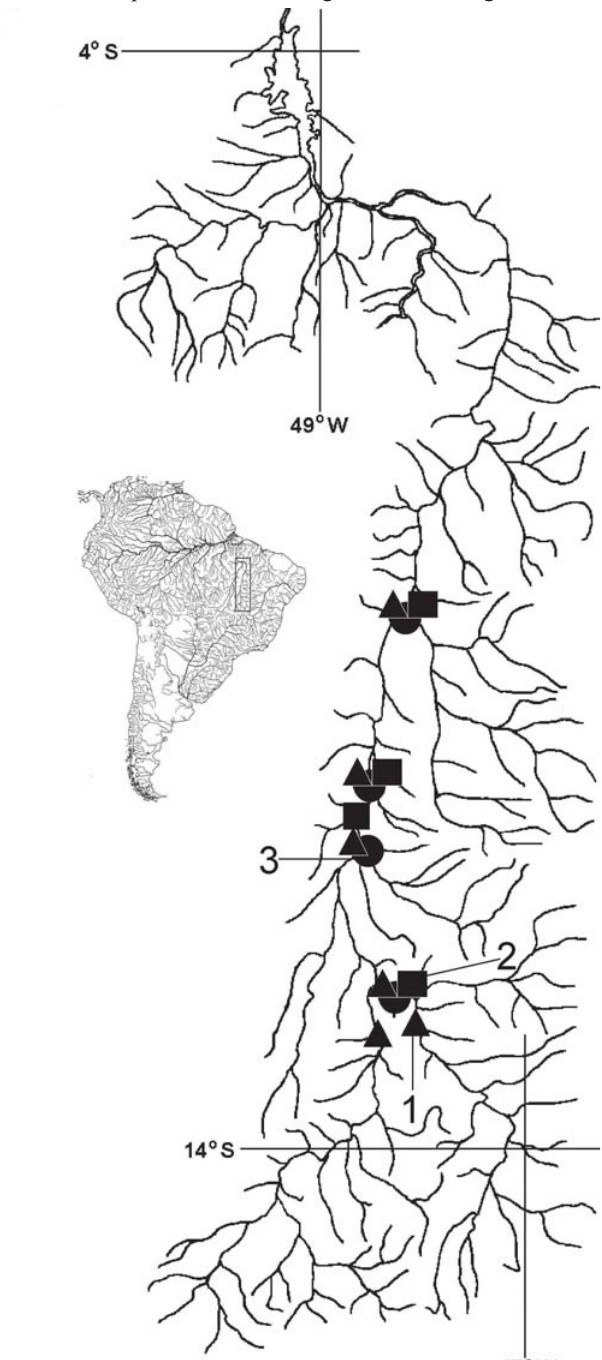
Fig. 2. Rio Tocantins drainage showing the collection locali- ties of Pimelodus stewarti (triangles, 1), P . halisodous (squares, 2), and P . joannis (circles, 3). Numbers represent type-locali- ties. Some symbols represent more than one lot or